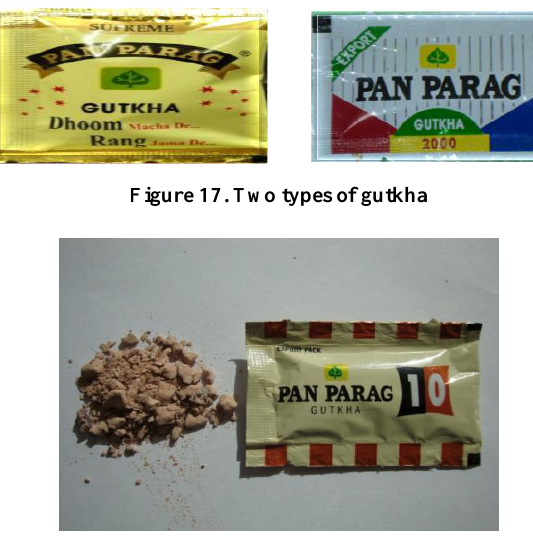
Figure 18. A package of one kind of gutkha (Pan Parag) with the content poured